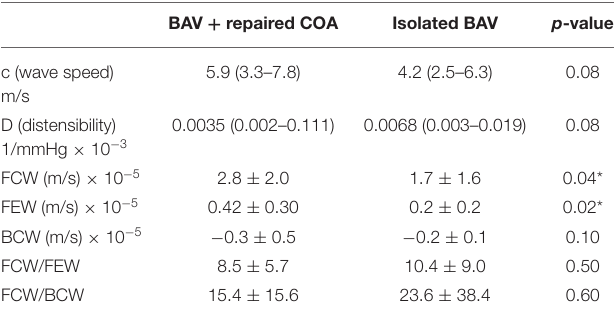
TABLE 3 | Wave intensity analysis results for the BAV patients with and without COA (BAV + COA vs. isolated